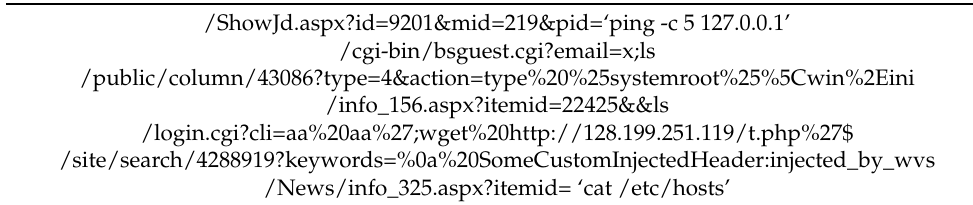
Table 2. The sample data of URLs in command injection